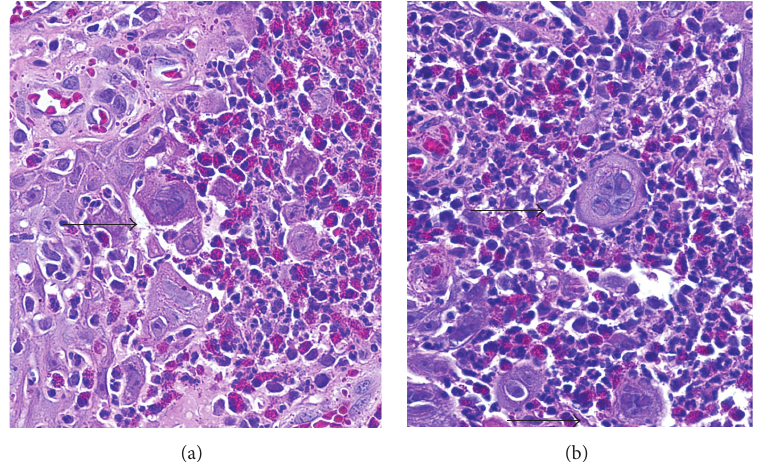
Figure 3: (a) Histopathologic appearance showing epithelial cell with viral inclusions. (b) Histopathologic appearance showing multinucle- ated cells (HE, original magnification × 400).